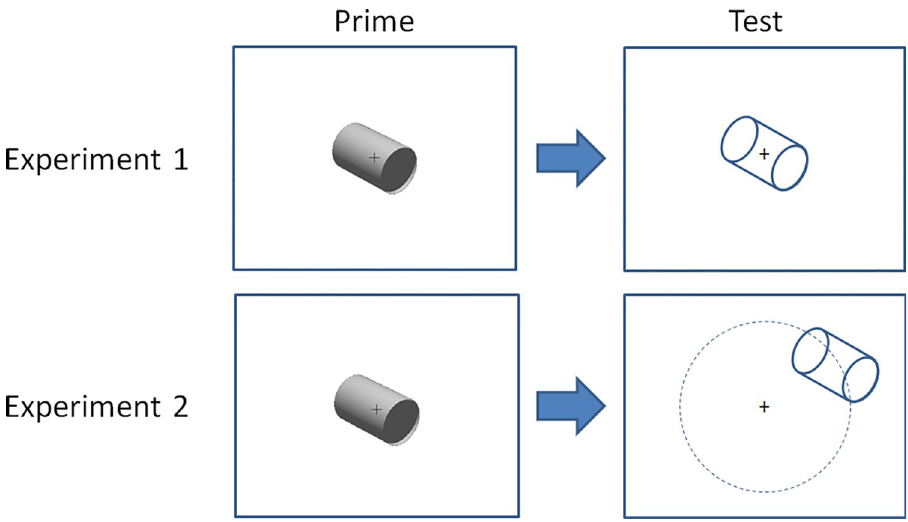
Fig 3. Priming in Experiment 1 and 2. In Experiment 1, the test stimulus was located at the same position as the previously presented prime. In Experiment 2, the test stimulus was randomly located along a circle with a fixed radius around the